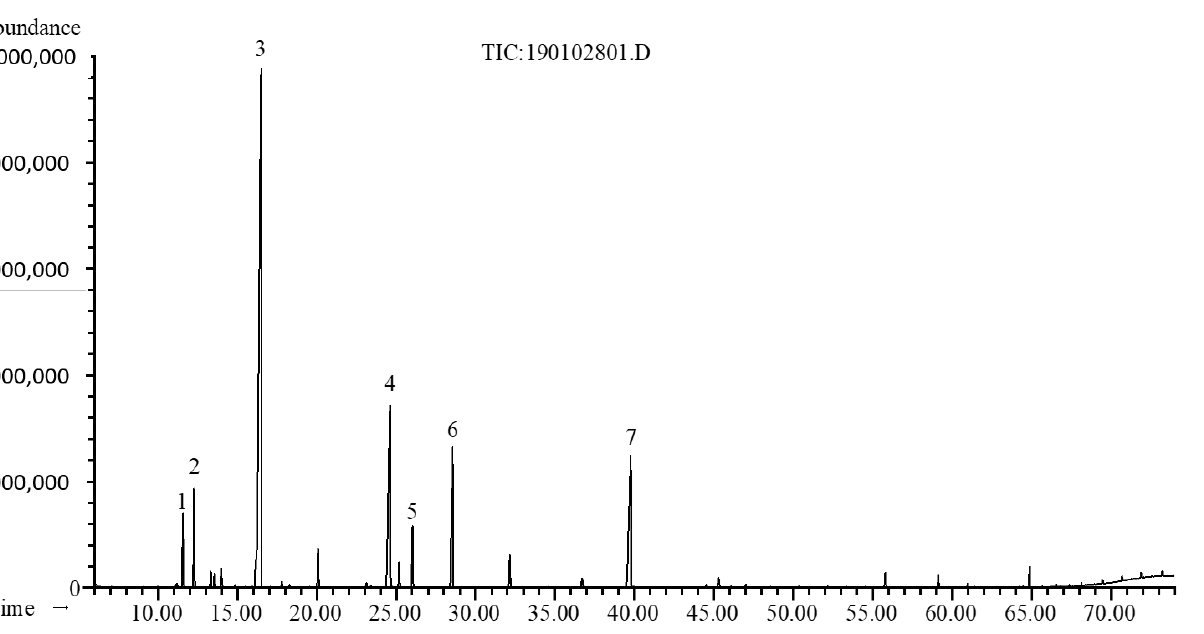
Figure 1. Gas chromatography with mass selective detection (GC-MS) chromatogram of R. beesianus rhizome essential oil (EO). Table 1. Chemical composition of the essential oil from R. beesianus rhizome. Compounds a